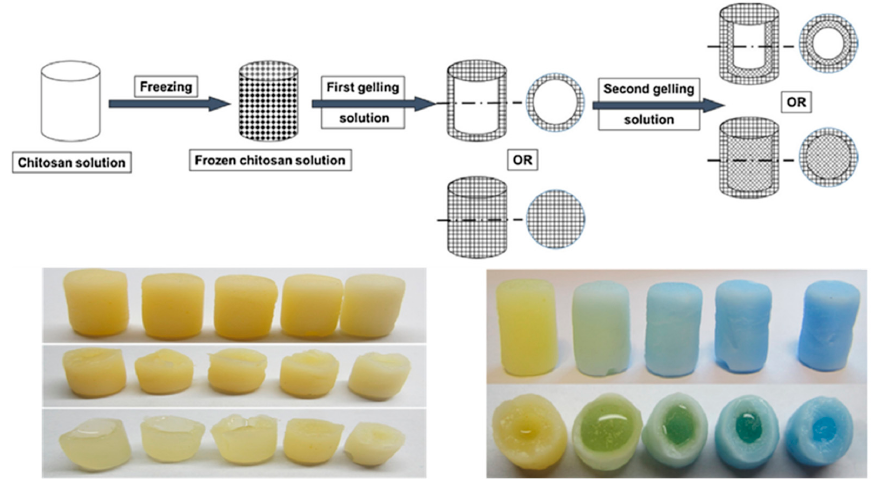
Figure 6. The schematic illustration of the preparation of the chitosan-based hydrogel; insert: photo images of the obtained hydrogel materials, adopted from [35] with permission from Elsevier through copyright clearance center.